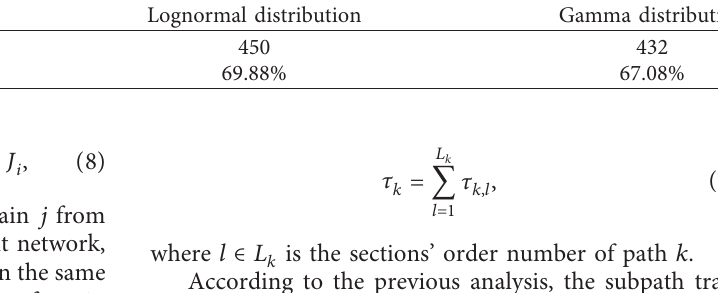
Table 2: The KS test statistical result of egress time